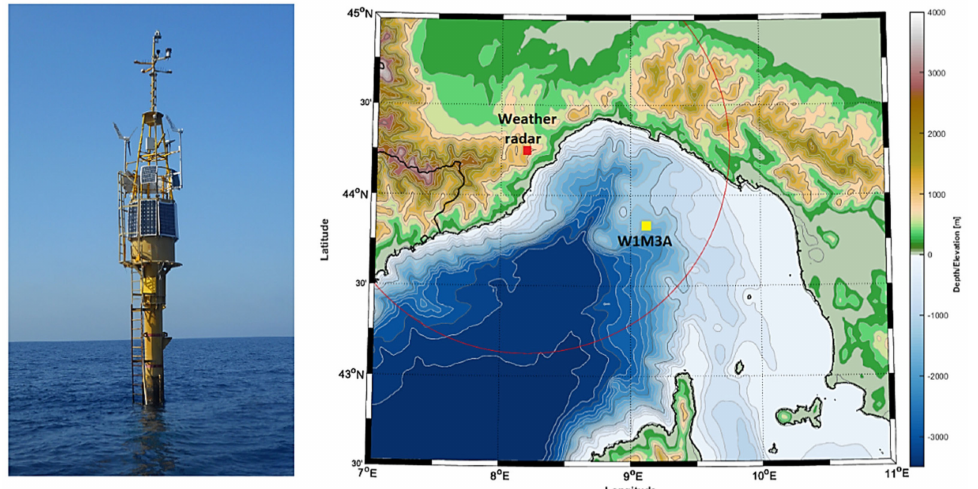
Figure 1. A photo of the surface buoy of the W1M3A observing system and the map of the Ligurian basin. The yellow square marks the position of the W1M3A observing system, whereas the red circle shows the operational range of the weather radar marked as the red